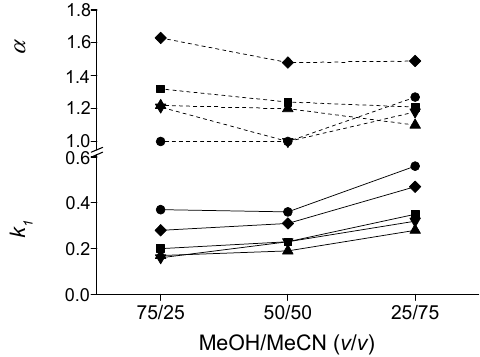
Figure 3. Effects of the bulk solvent composition on chromatographic parameters, k 1 and α . Chromatographic conditions: column, ZWIX(+)™; mobile phase, MeOH/MeCN (70/25, 50/50 and 25/75 v/v ) all containing 30 mM TEA and 60 mM FA; flow rate, 0.6 mL·min − 1 ; detection, 262 nm; symbols: for Fmoc-Asp(O t Bu)-OH; for Fmoc-Phe-OH; for Fmoc-Leu-OH; for Fmoc-Lys(Boc)-OH; and for Fmoc-Tyr( t Bu)-OH.